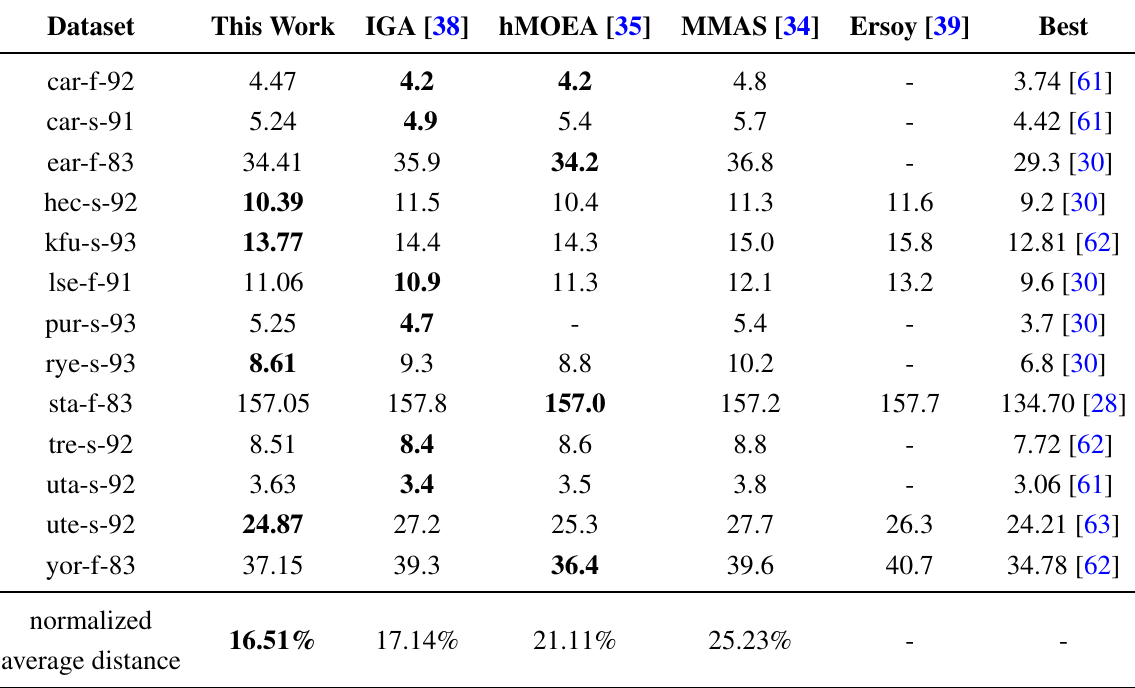
Table 10. A comparison with other evolutionary approaches and the best solution